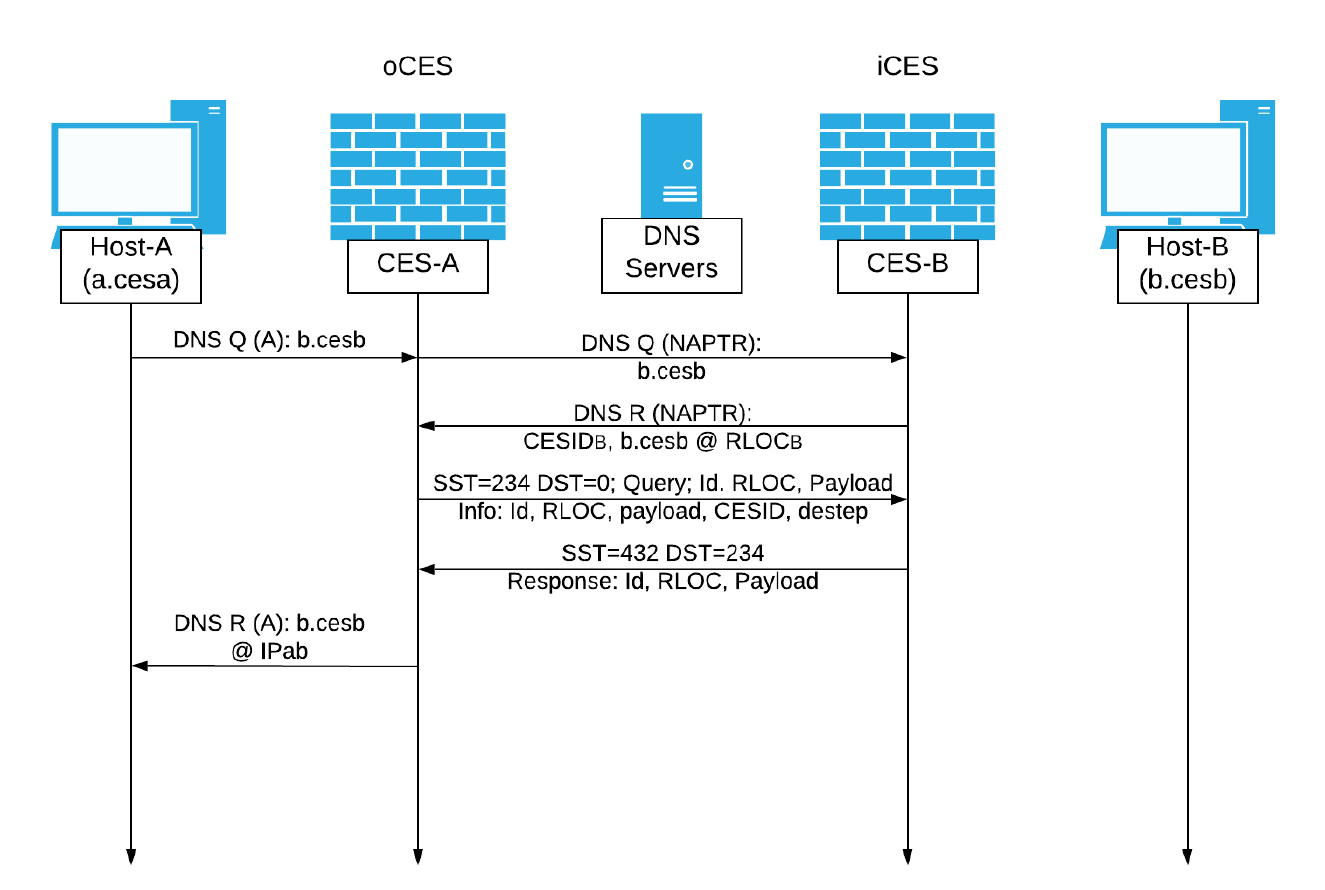
Figure 7. CETP connection establishment-–1 RTT